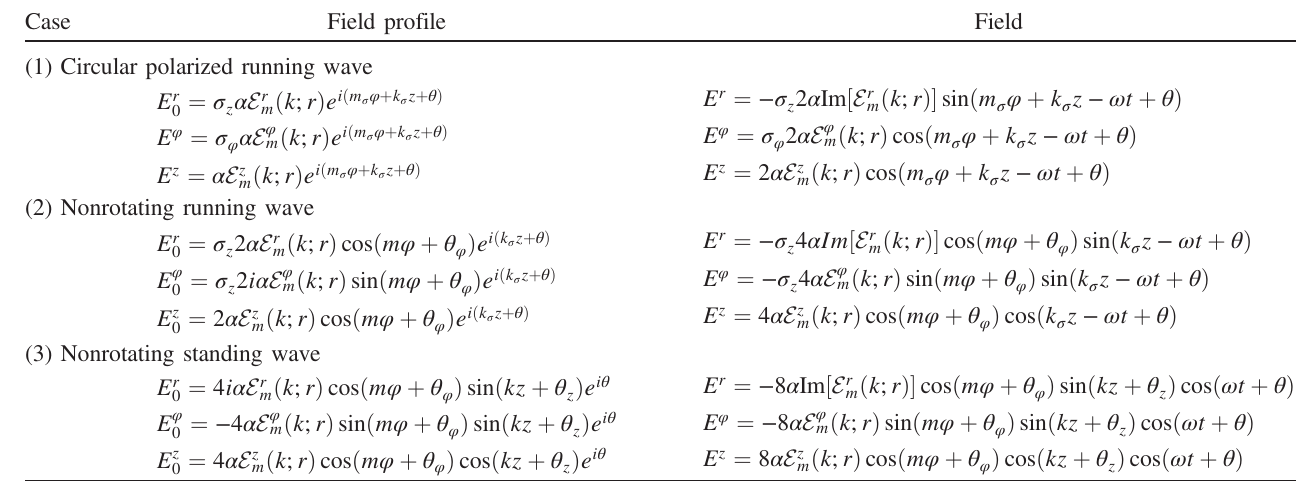
TABLE XVII. Electric fields of monochromatic waves of frequency ω on the HE propagation direction along the fiber axis, the sign σ φ the rotation direction around the axis. The propagation constant is k σ ¼ σ k > 0 , the azimuthal order m σ ¼ σ φ σ θ θ ∈ R are phases explained in the text. The radial partial waves E i φ , z